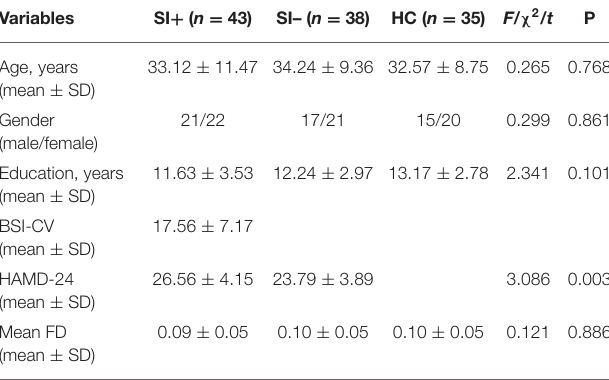
TABLE 1 | Demographics and clinical characteristics of all participants.